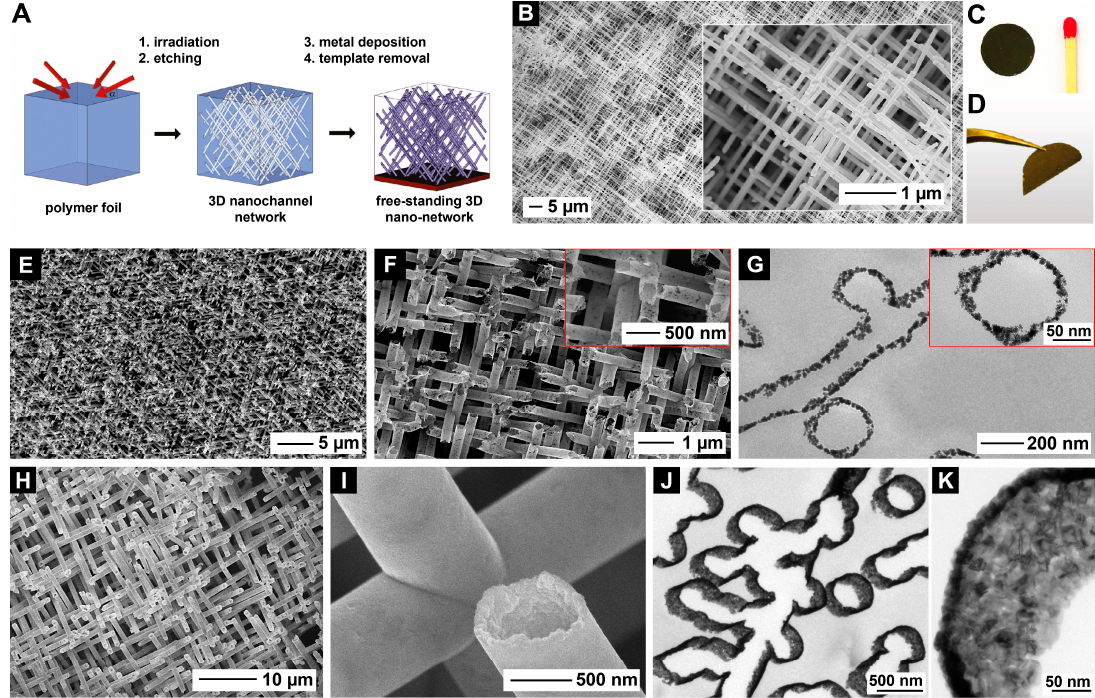
Figure 8. ( A ) Scheme of the fabrication of 3D nano-networks using ion-track etched polymer templates. ( B ) Electrodeposited 3D Pt nanowire network. ( C , D ) Photographs illustrating the size and the robust, free-standing nature of 3D Pt nanowire networks, which allows manipulating them with